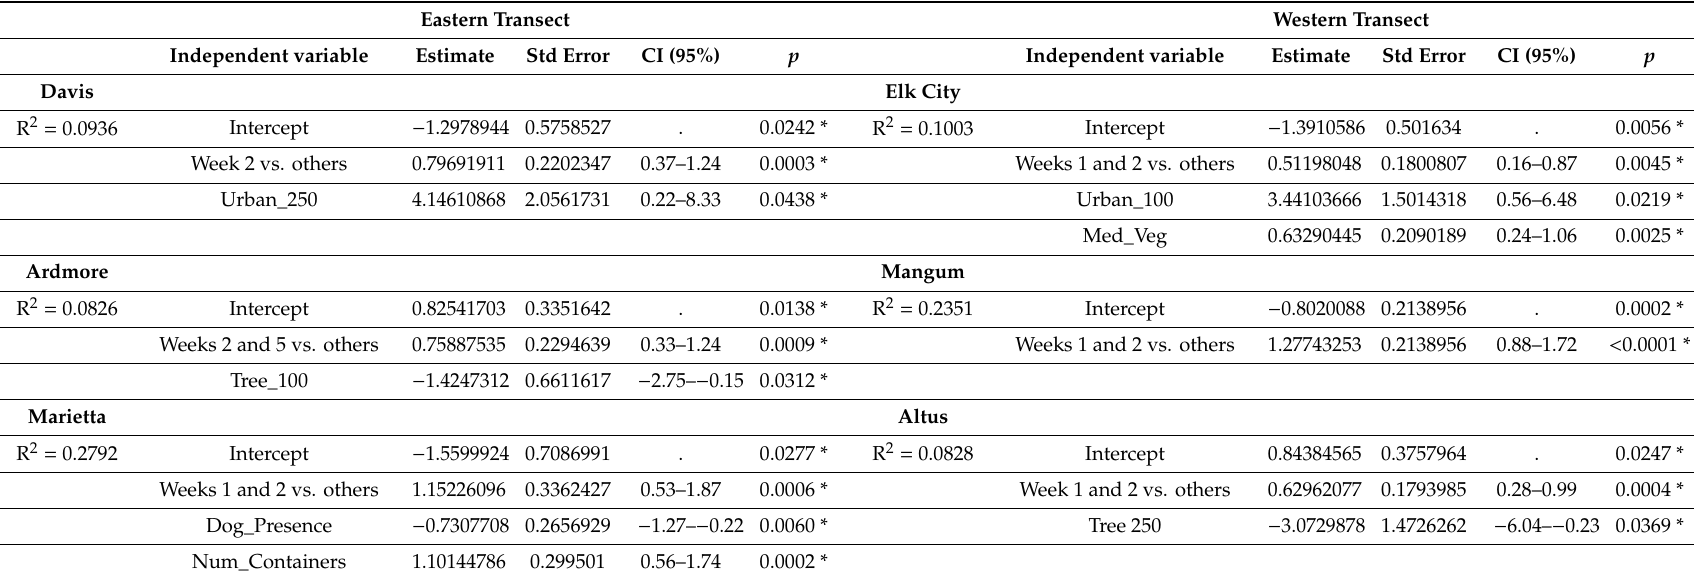
Table 4. Stepwise logistic regression analysis of Ae. albopictus presence with minimum AICc in a forward direction with landscape, spatiotemporal and anthropogenic variables in six cities in Oklahoma between June and August